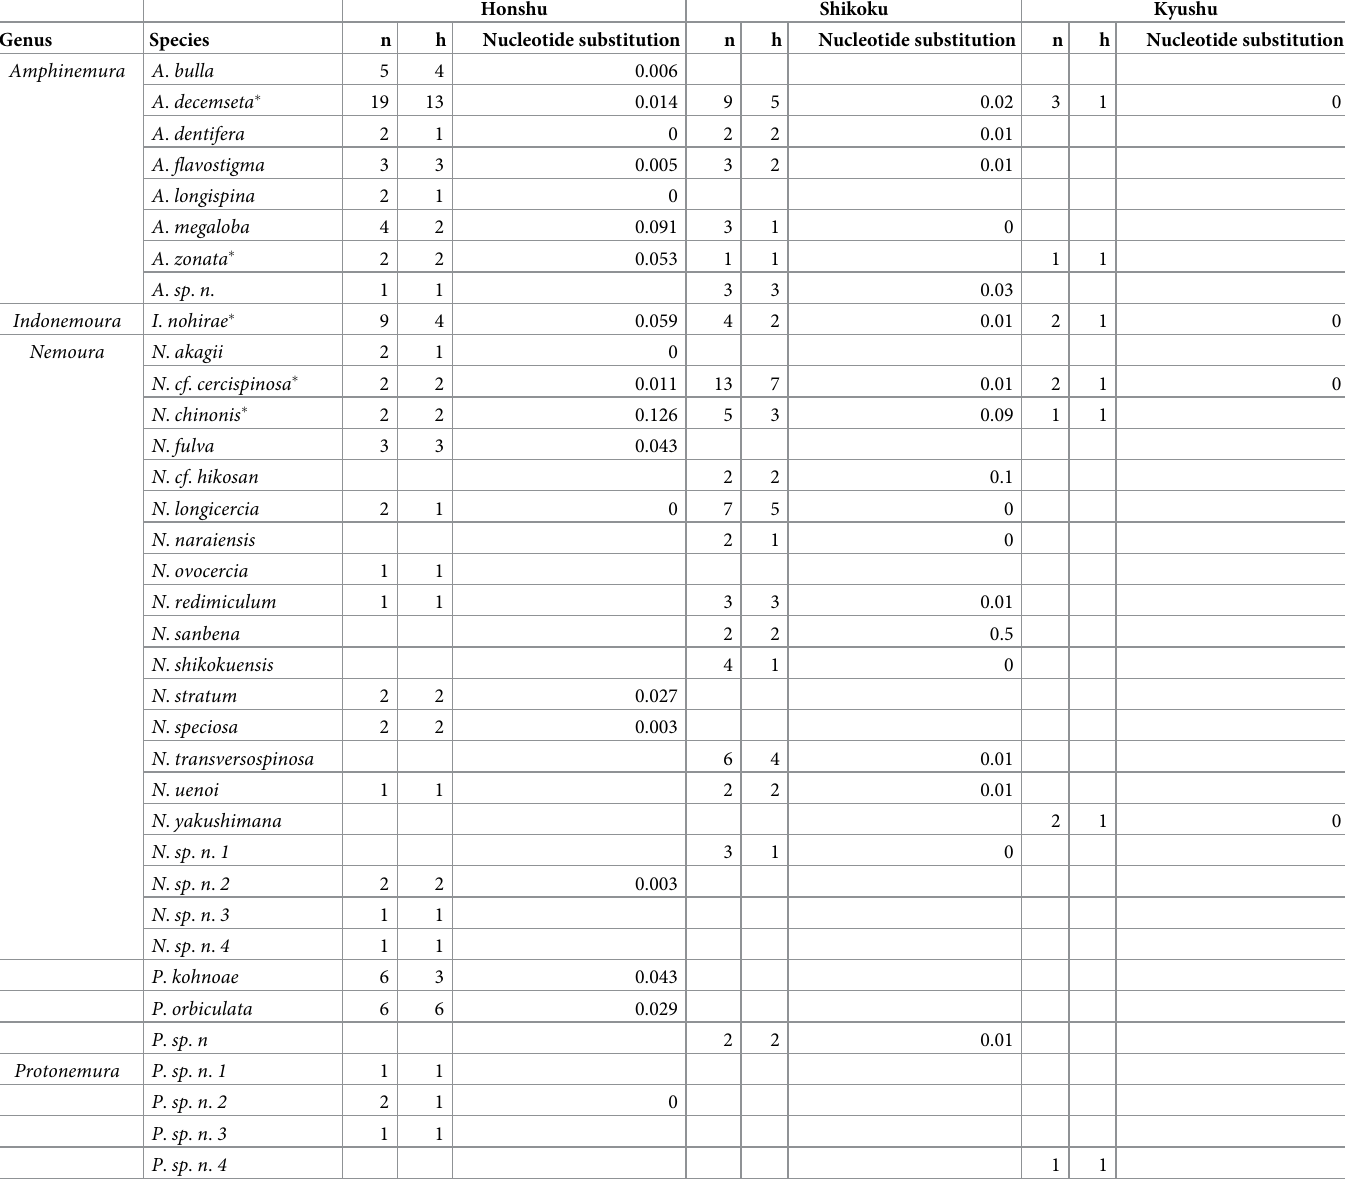
Table 1. Regional distribution of sample size (n), haplotype richness (h) and mean nucleotide substitution rate of Nemouridae species among the three main islands in Japan, based on mitochondrial DNA ( cox1 ) sequences. Total species richness was 26, 23 and 6 for Honshu, Shikoku and Kyushu, respectively.